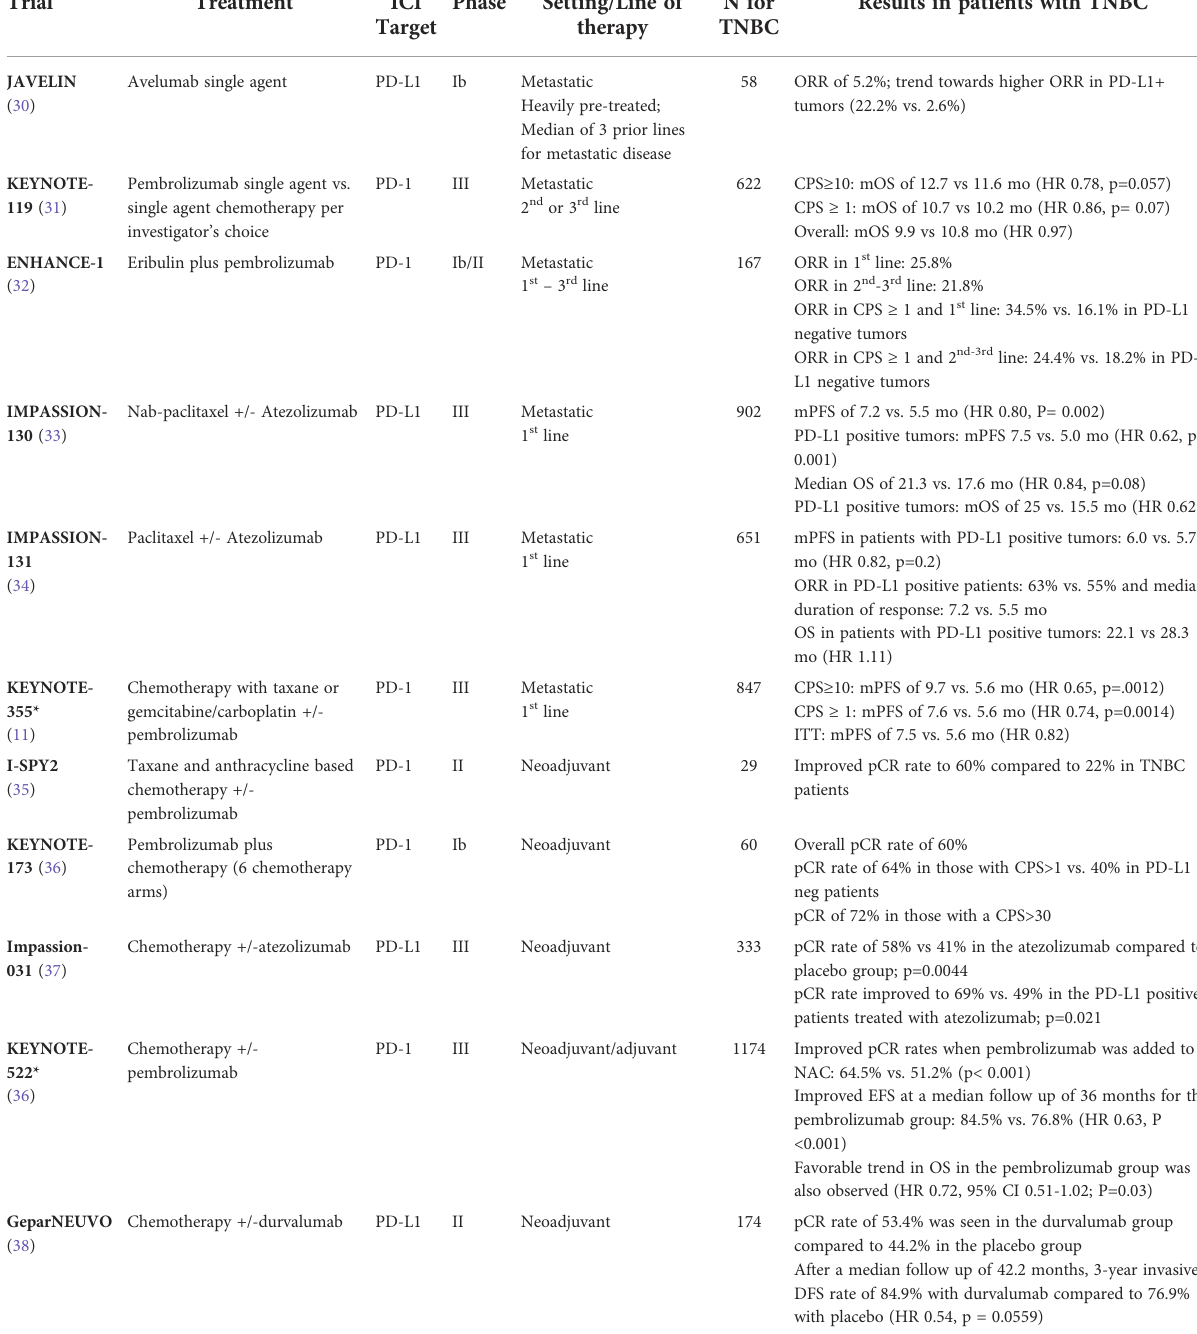
TABLE 1 Clinical trials of immune checkpoint inhibitors in breast